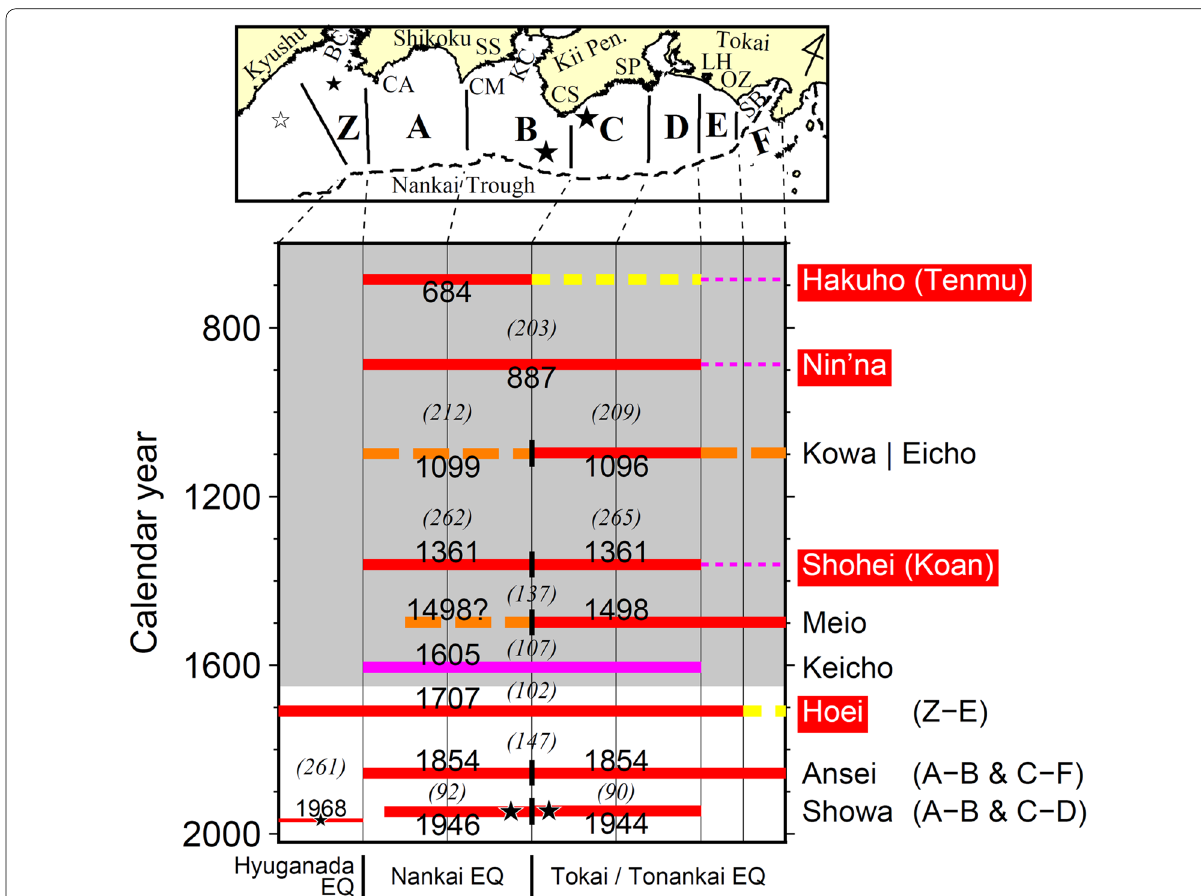
Fig. 1 Historical great earthquakes along the Nankai Trough. (Upper) Map showing the rupture segmentation of historical earthquakes. From right to left, stars indicate epicenters of the 1944 Tonankai (region C), 1946 Nankai (region B), 1968 Hyuganada (region Z), and 1662 Hyuganada earthquakes (out of region Z). BC Bungo Channel, CA Cape Ashizuri, CM Cape Muroto, SS Shishikui, KC Kii Channel, CS Cape Shiono, SP Shima Peninsula, LH Lake Hamana, OZ Omaezaki, SB Suruga Bay. (Lower) Timeline of historical earthquakes (Earthquake Research Committee 2013) showing the extent of rupture zones (segment boundaries are shown by vertical lines). Red lines indicate source segments known to have ruptured during historical events. Broken lines indicate probable (orange) and possible (yellow) ruptured segments. The solid purple line indicates a tsunami earthquake or teleseism. The dashed purple lines indicate ruptured segments according to previous studies (Earthquake Research Committee 2013). Italic numerals in parentheses indicate the time intervals between successive earthquakes. Historical records are considered incomplete before 1605 (shaded area). Historical events are named on the right side; names with red backgrounds indicate mega-earthquakes (Maemoku 1988; Shishikura et al. 2008; Okamura and Matsuoka